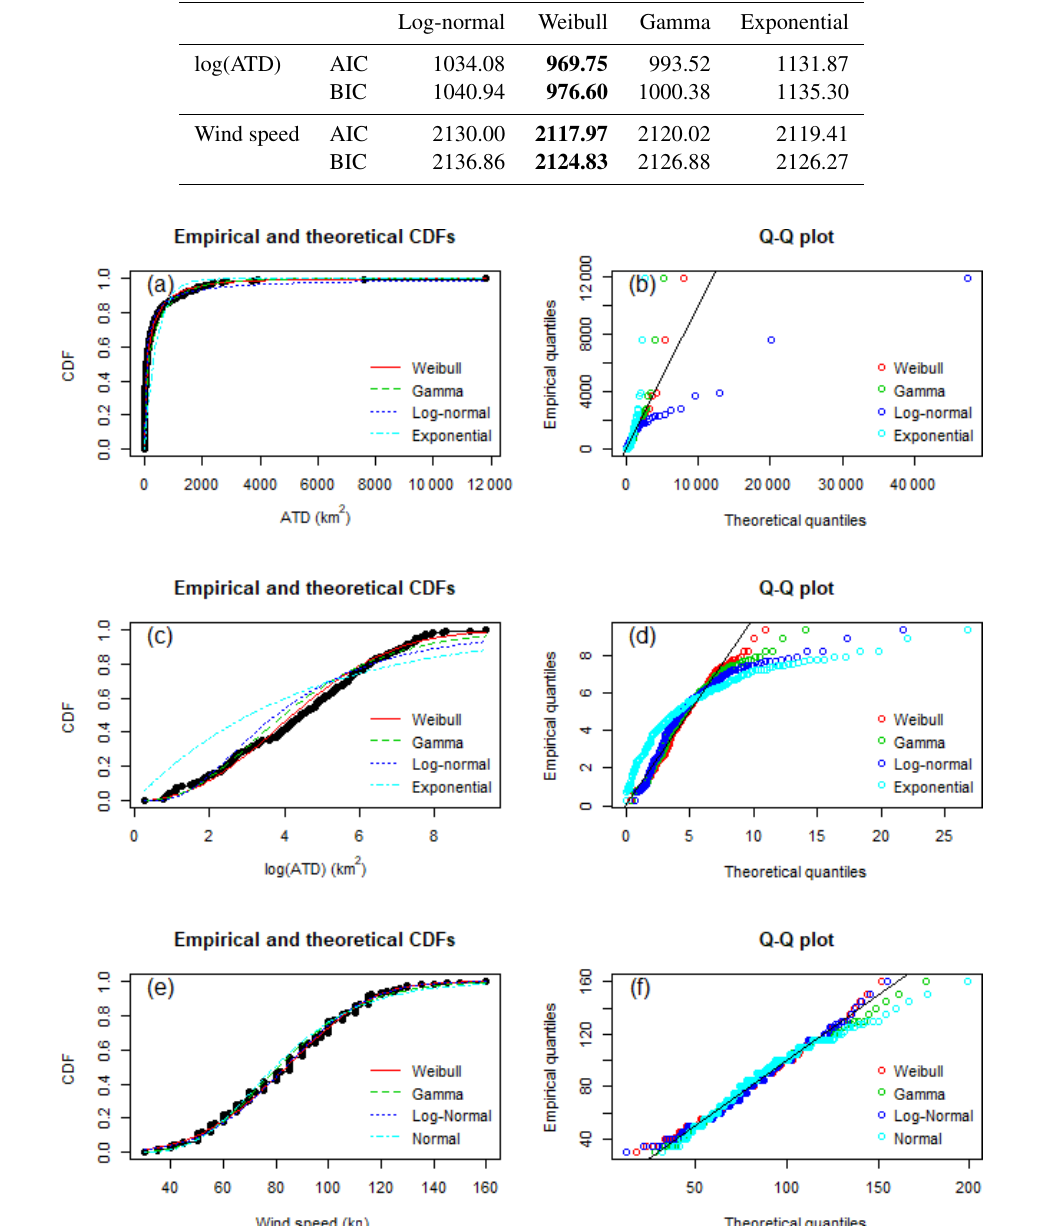
Table 4. Marginal distribution goodness-of-fit AIC and BIC measures for log-transformed ATD and maximum landfalling wind speed and smallest values highlighted in bold.